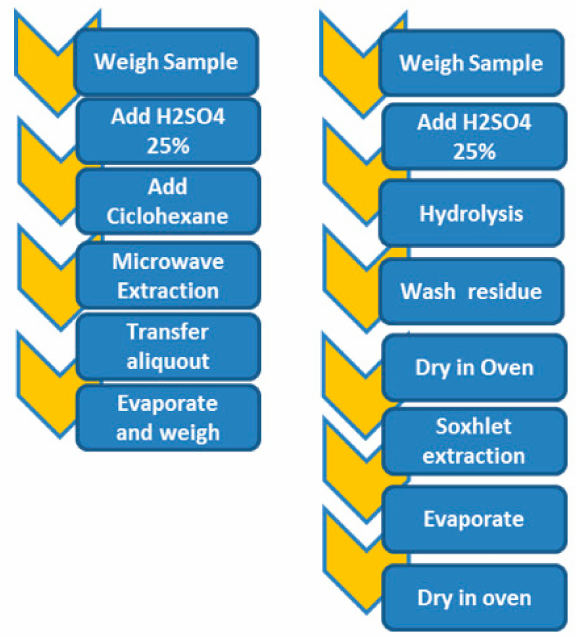
Figure 2. Closed-vessel microwave extraction and Soxhlet-based method workflow comparison.